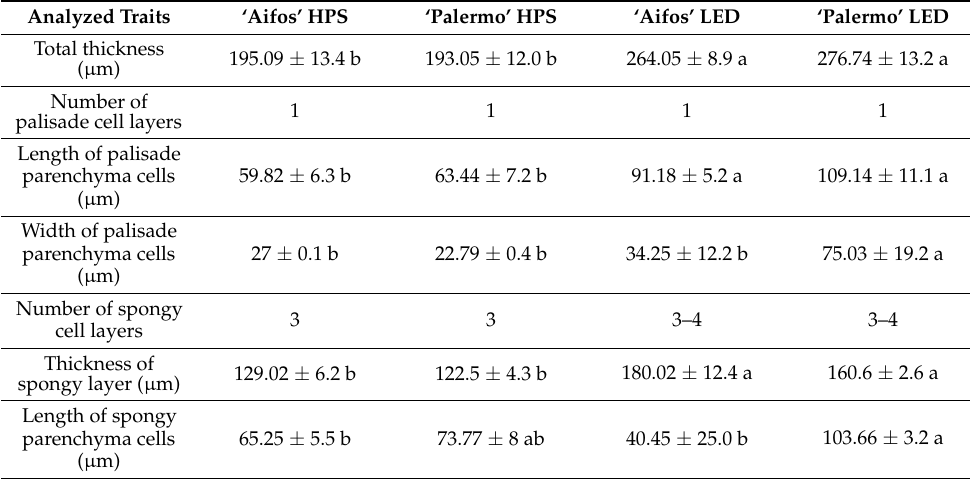
Table 2. Analyzed leaf traits depending on the type of supplementary lighting and cultivar.